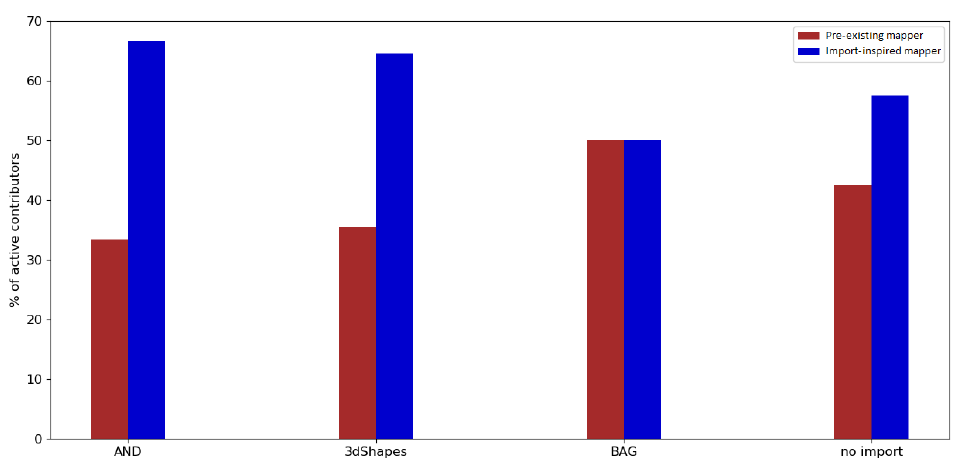
Figure 4. Ratio of pre-existing mappers to import-inspired mappers during an import in the Nether- lands.